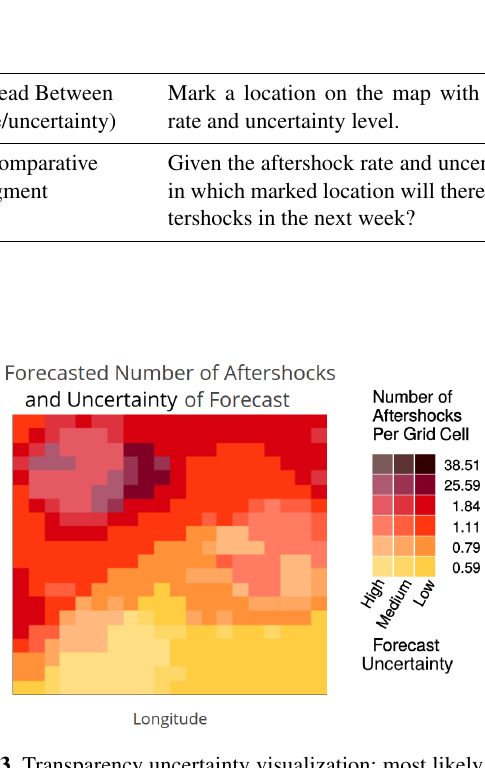
Figure 3. Transparency uncertainty visualization: most likely fore- casted aftershock rate in color and uncertainty levels shown by transparency (alpha level) of rate